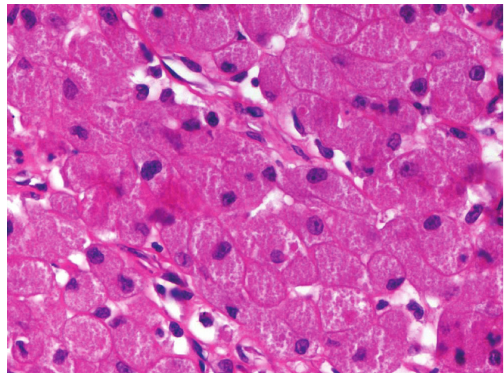
Figure 2: Intraoperative view showing the pedunculated nature of the mass arising from the lower alveolar ridge. The upper mass has been removed.